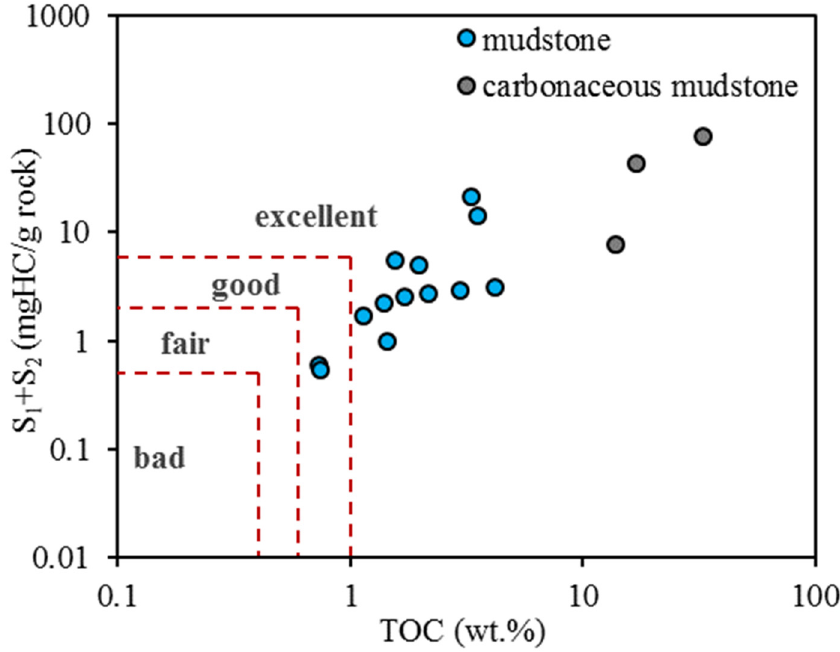
Figure 3. Organic matter abundance of coal-measure source rocks.